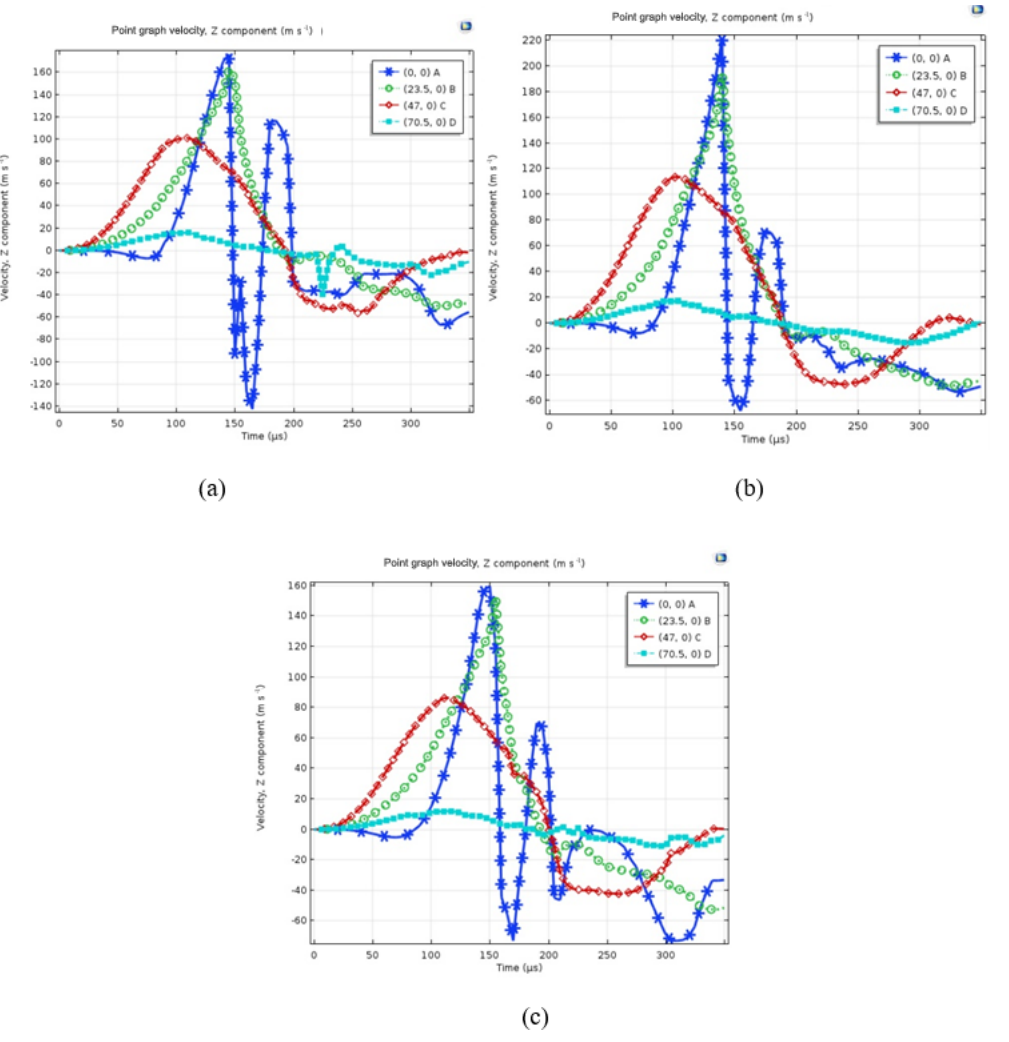
Figure 13. Velocity of four points on sheets. (a) Voltage = 2400V, thickness = 1.02mm, N = 6. (b) Voltage = 2800V, thickness = 1.22mm, N = 6. (c) Voltage = 2600V, thickness = 1.63mm, N = 6.